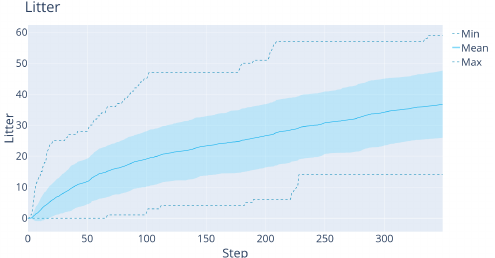
Figure 18. The results with the Rainbow agent and the shallow network. Here, h =